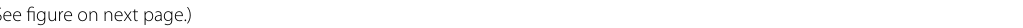
figure on next Fig. 2 Morphology of 3 Eimeria species recovered from examined sheep. a Eimeria bakuensis unsporulated oocyst. Note the distinct polar cap (arrow). b Eimeria bakuensis sporulated oocyst. c Eimeria weybridgensis unsporulated oocyst. Note an ellipsoidal to a spherical shape with a smooth wall (arrow). d Eimeria weybridgensis sporulated oocyst. e Eimeria ahsata unsporulated oocyst. Note the smooth wall with yellowish brown coloration (arrow). f Eimeria ahsata sporulated oocyst. (Scale bar 10 =